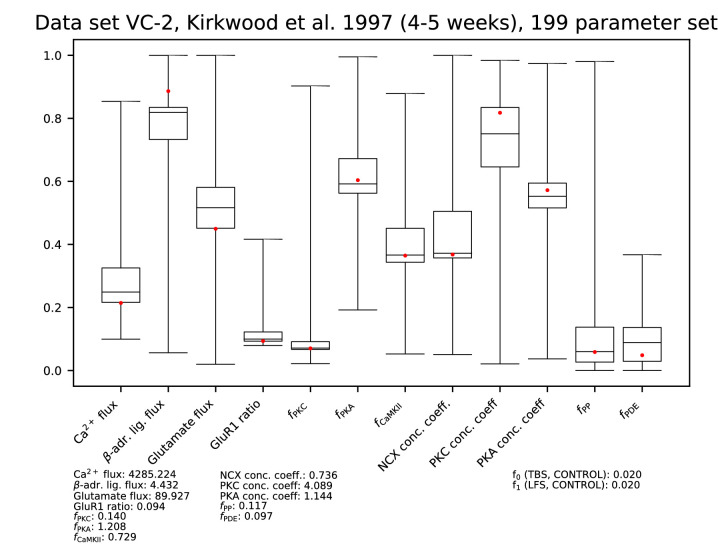
Parameters for data set VC-2.See Figure 9—figure supplement 1 for details.